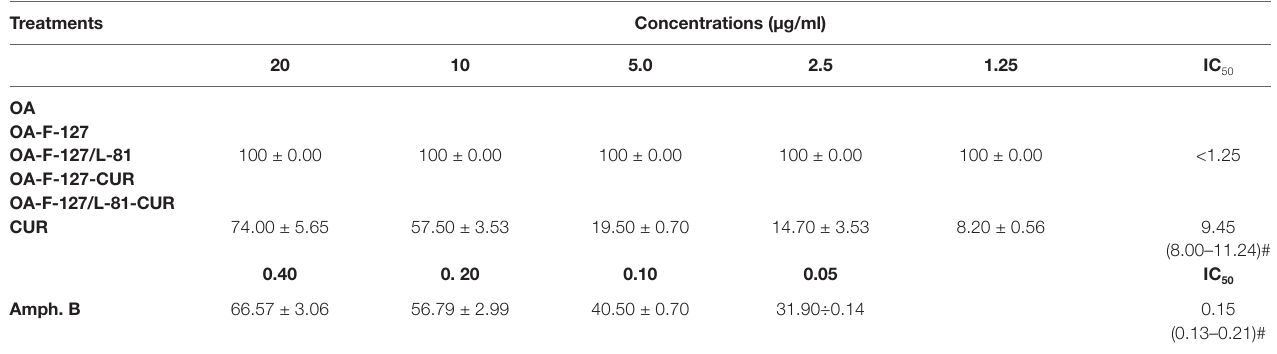
Results were expressed as the mean percentage of growth inhibition relative to the negative control. Two experiments were performed in triplicate. The 50% inhibitory concentration values (IC 50 ) and 95% confidence limits (in parenthesis) were determined by non-linear regression curves. Positive control: amphotericin B, Amph. B; negative control: medium RPMI +0.1% dimethylsulfoxide. F-127, Pluronic® F-127; L-81, Pluronic® L-81; OA, oleic acid.